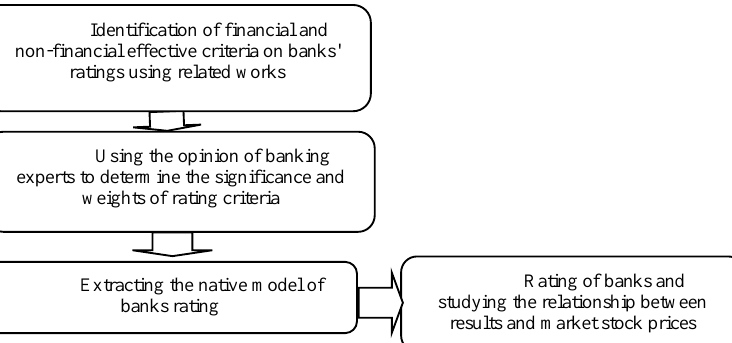
Figure 2. Overview of the research